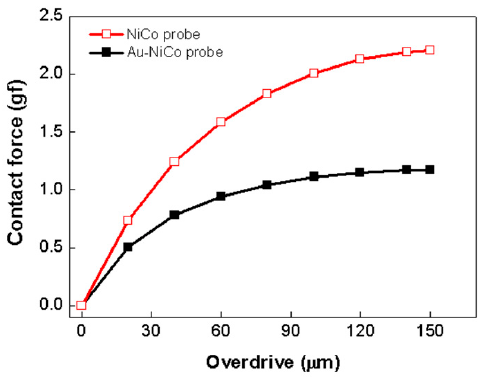
Figure 11. The variation in the contact forces with different overdrives for the TSV structure.